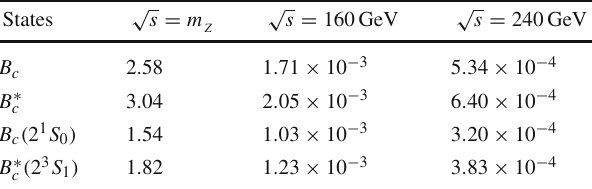
Table 1 The cross sections (in unit: pb ) for the production of the B c , B ∗ √ s = 240GeV under the fragmentation-function approach up to and